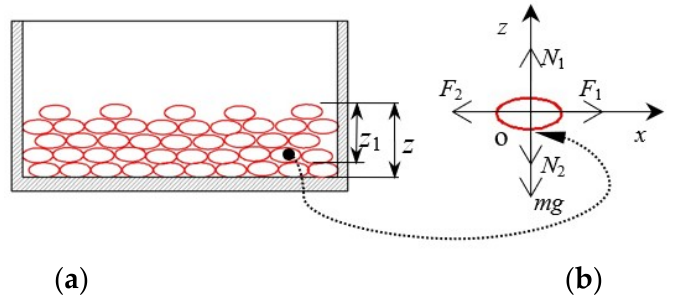
Figure 11. Force analysis of the bottom seed: ( a ) Height of the seed layer; ( b ) Stress analysis of the seed.